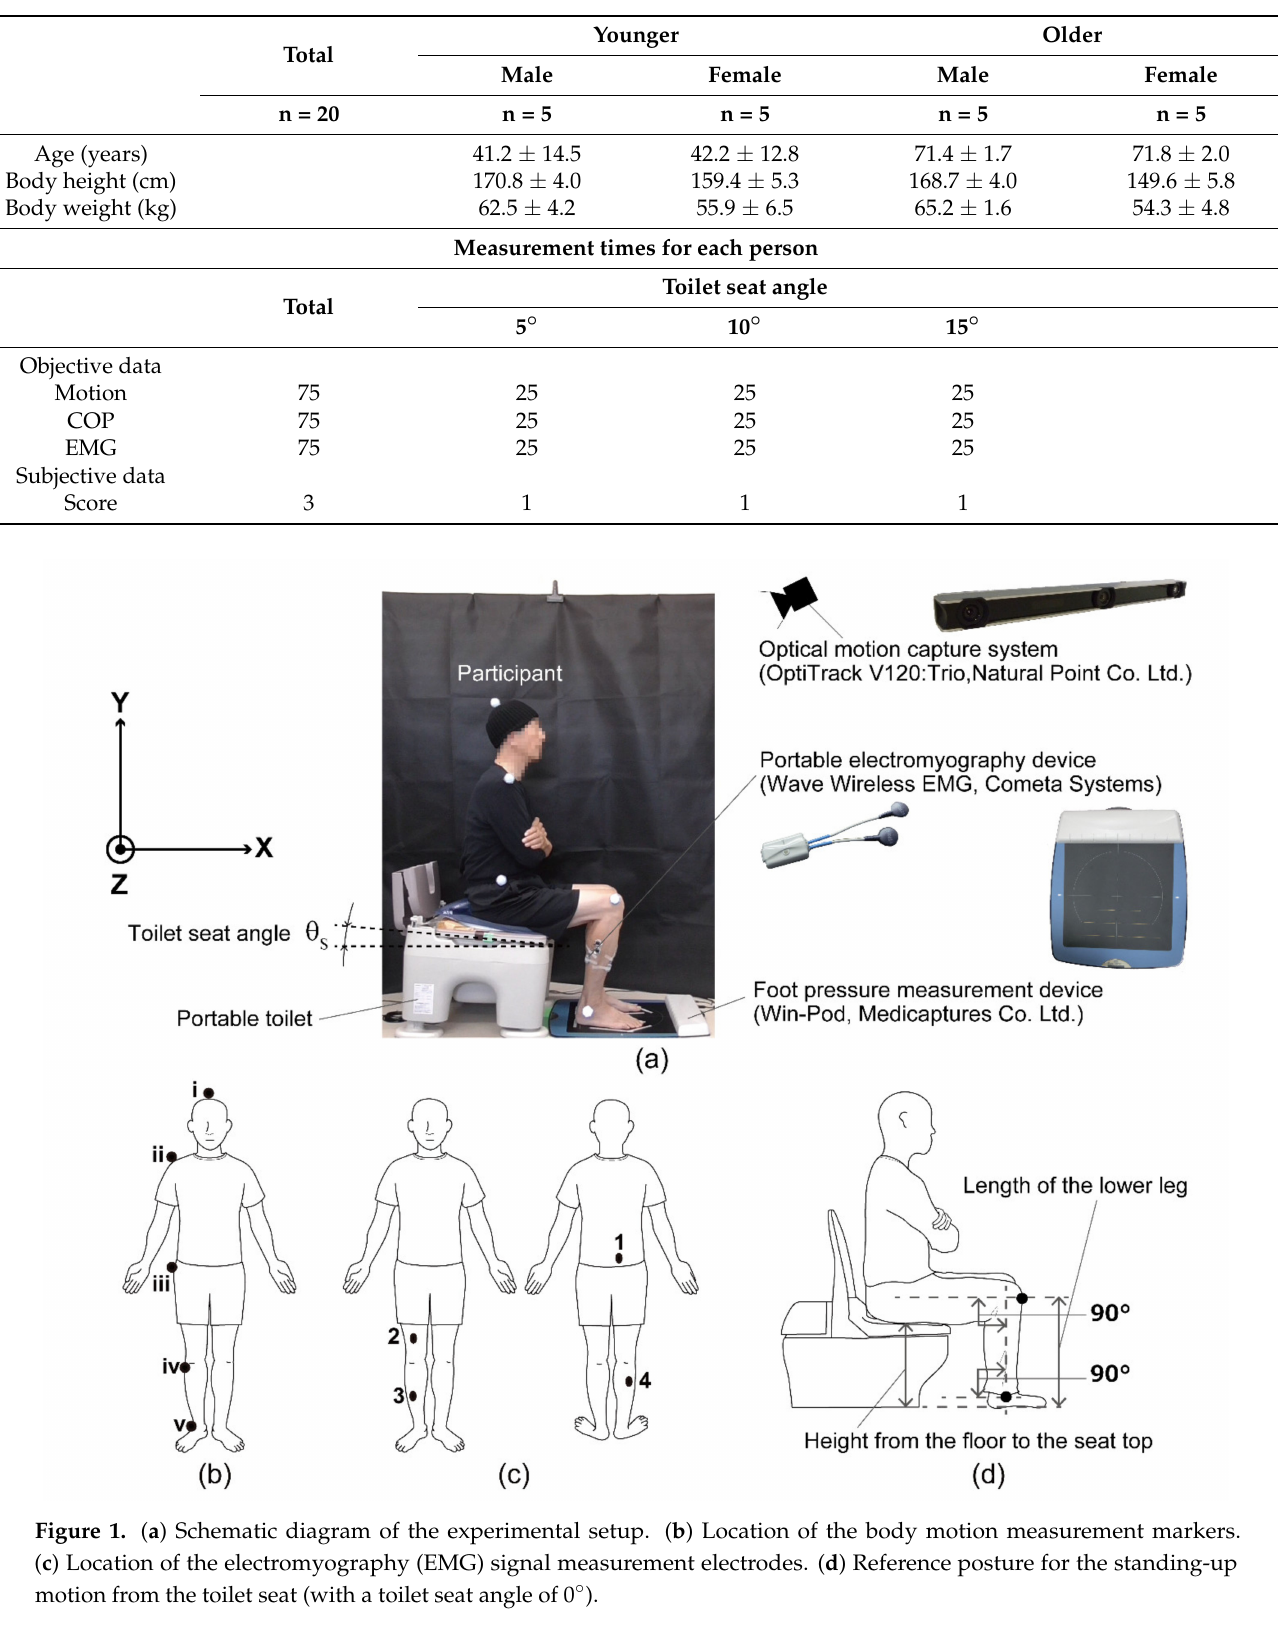
Table 1. Participant characteristics.